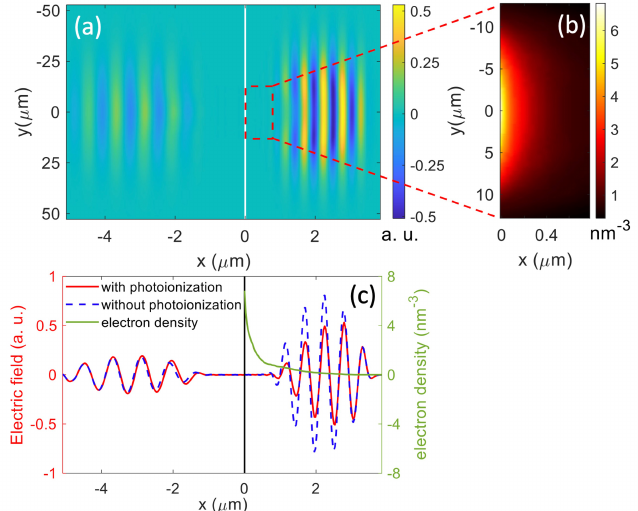
Figure 3. ( a ) Electric field distribution normalized to the amplitude of the incident pulse after the pulse leaves the target; ( b ) Electron density in the marked area; ( c ) Lineouts of electric fields (left panel) and electron density (right panel) with and without photoionization along y = 0. The vertical lines in ( a , c ) denote the air-and-target interface. The space on the left is air. The horizontal axes and scales in ( a , c ) directly correspond to each